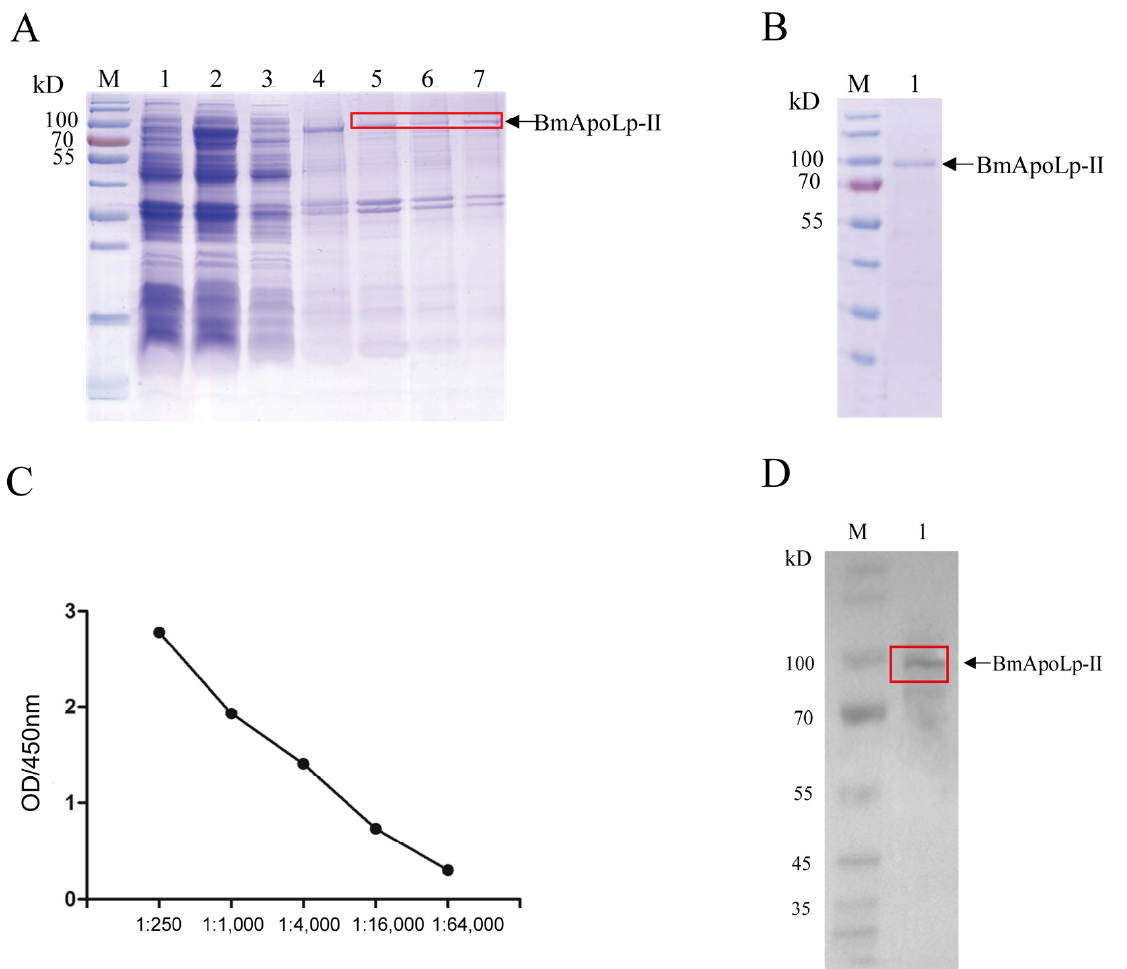
Figure 2. Preparation of polyclonal antibody against BmApoLp-II protein. ( A ) Prokaryotic expres- sion and purification of BmApoLp-II. M: Pre-stained protein marker; 1: uninduced BL21; 2: induced BL21; 3: Supernatant of ultrasonic fragmentation; 4: Precipitation of ultrasonic fragmentation; 5: Elution by 100 mM imidazole; 6: Elution by 150 mM imidazole; 7: Elution by 200 mM imidazole. ( B ) Puri fi cation of BmApoLp-II by ultra fi ltration. M: Pre-stained protein marker; 1: Puri fi ed BmApoLp- II protein. ( C ) Determination of the titer of anti-BmApoLp-II polyclonal antibody from rabbit serum. ( D ) Identi fi cation of the polyclonal antibody against BmApoLp-II. M: Pre-stained protein marker; 1: The lysis of BmN cells. Red box represents the band of BmApoLp-II protein .